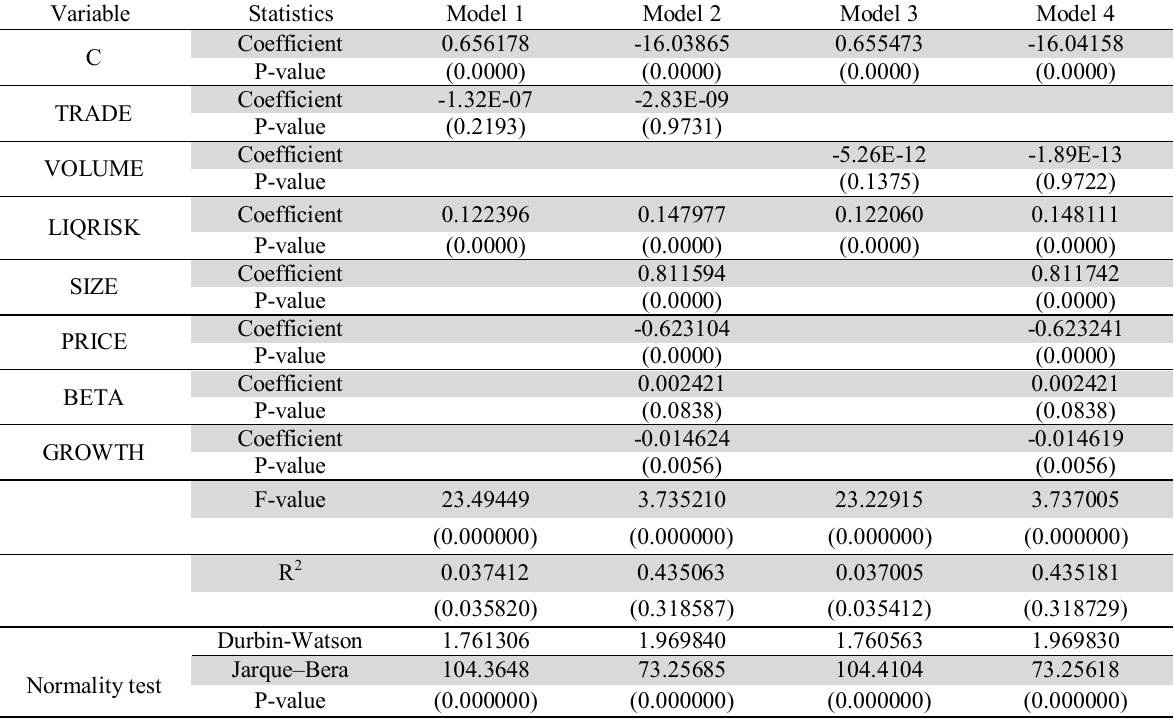
The summary of regression model for four